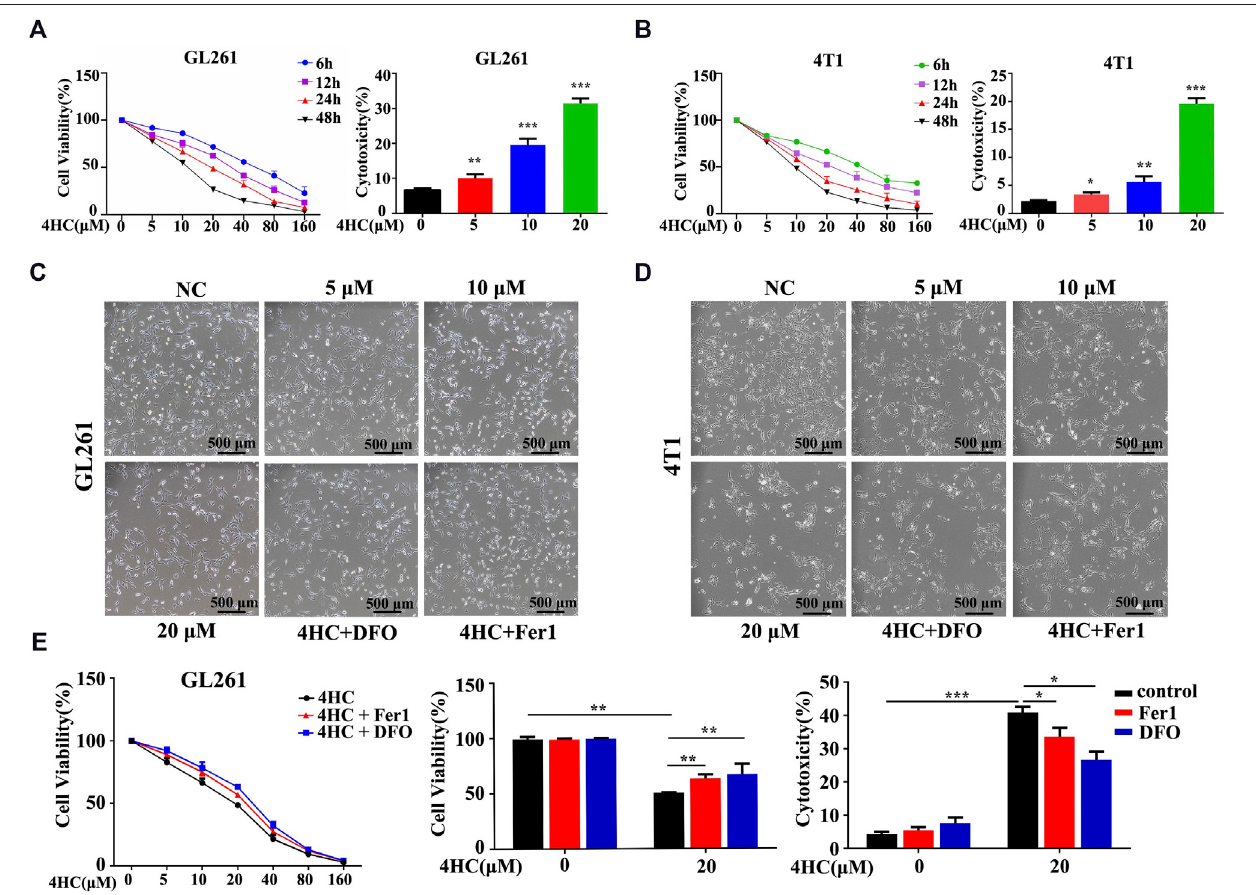
FIGURE2| Ferroptosisinhibitorsreversed4HC-inducedcytotoxicity (A – B) GL261and4T1celllinesweretreatedwithdifferentconcentrationsof4HC(0 – 160 μ M) for 6, 12, 24 or 48 h (C – D) Cell morphology was photographed under an inverted microscope, and representative images from experiments with similar results are shown (scale bar = 500 μ m) (E) GL261 cell line was preincubated with Fer1 (10 μ M) or DFO (400 μ M) for 1 h followed by 4HC (0 – 160 μ M) for 24 h. The values of cell viabilityandcytotoxicityarepresentedasthemeans±SDfrommorethanthreeindependentexperiments.* p < 0.05,** p < 0.01,and*** p < 0.001(one-wayANOVA analysis) for the indicated